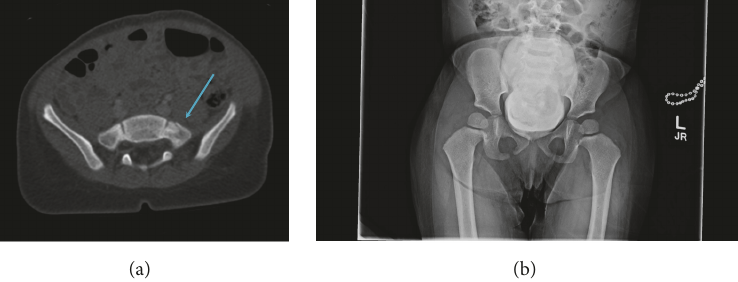
Figure 2: A 2-year-old female presented as a Level 1 Trauma;a contrast-enhancedCT of the abdomen and pelvis (a) was performed, revealing a left sacral fracture(arrow). Subsequently, a radiograph of the pelvis (b) did not demonstrate the same finding, secondary to marked bladder distention following contrast administration for the